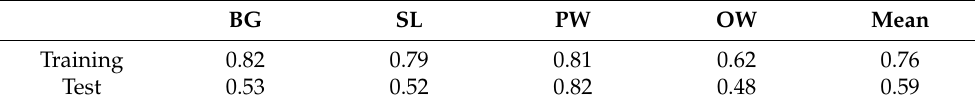
Table 20. IoU scores for Soybeans in Experiment